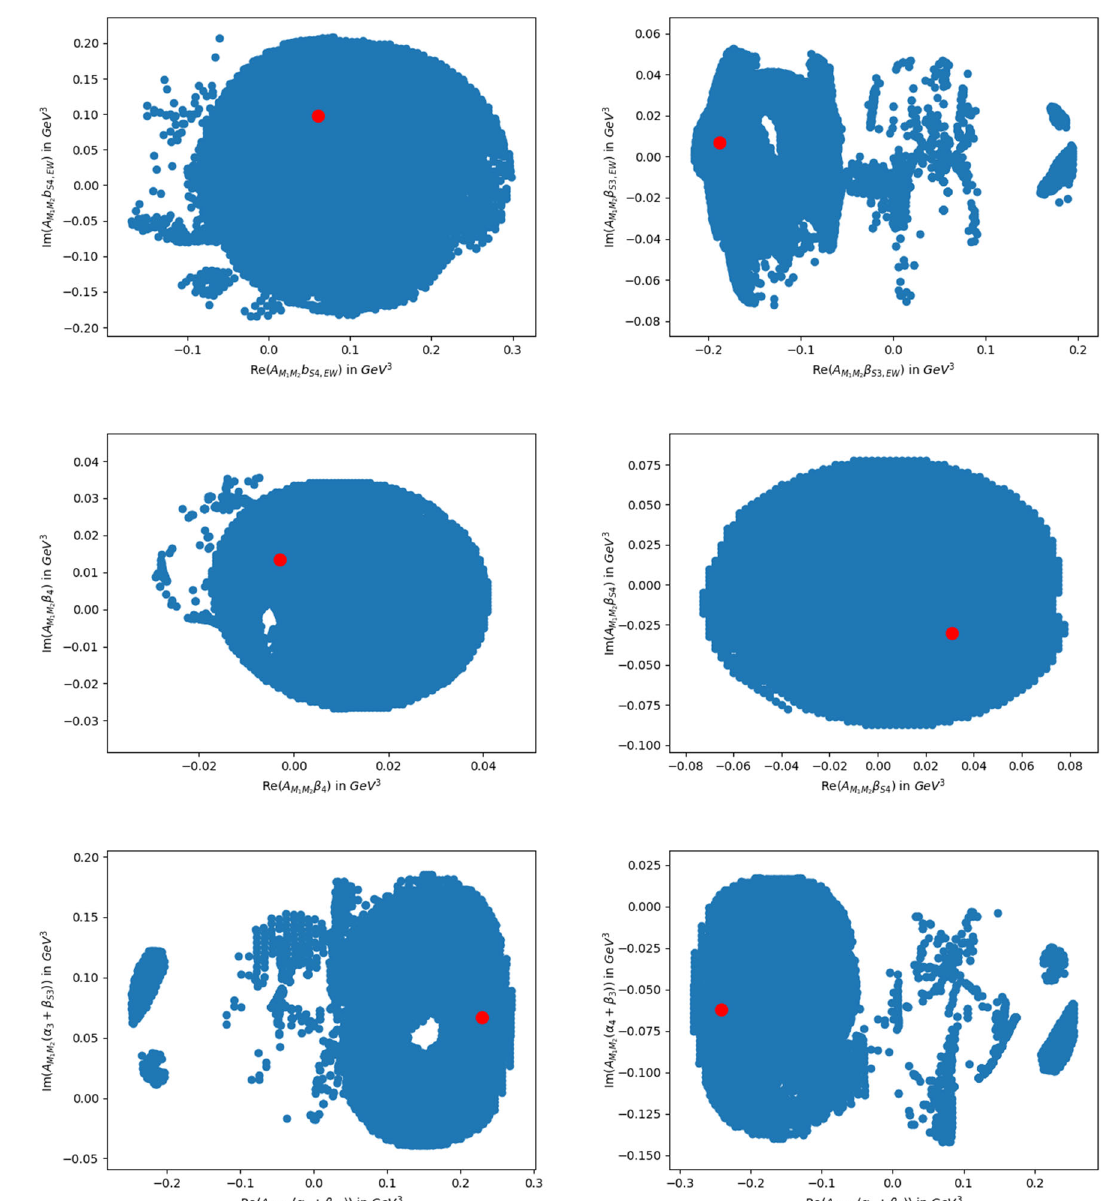
Fig. 6 QCDF fit, part2. Amplitudes carry units of GeV